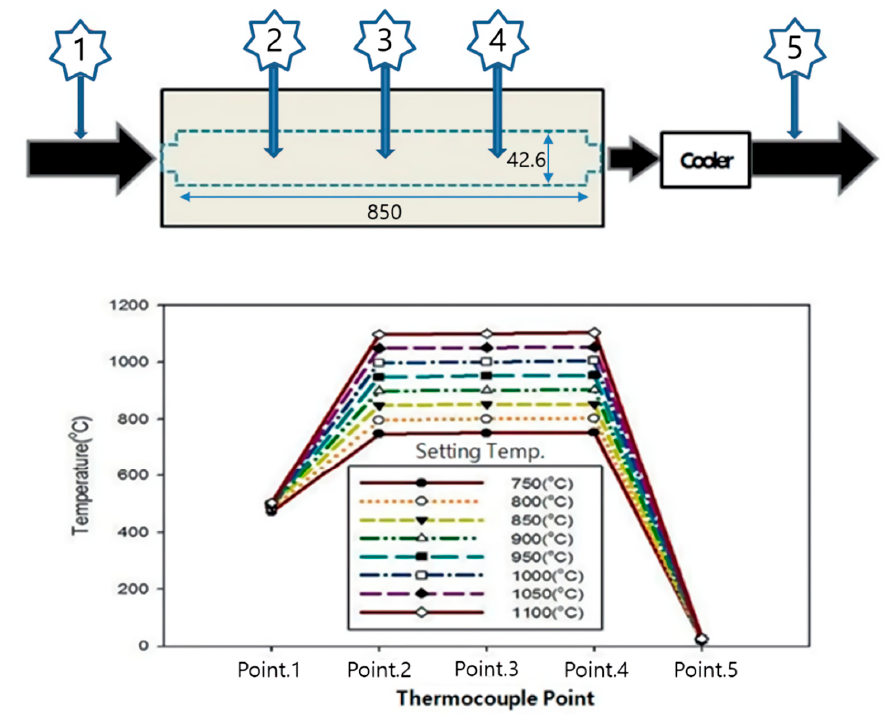
Figure 2. Temperature profile within the SNCR reactor.